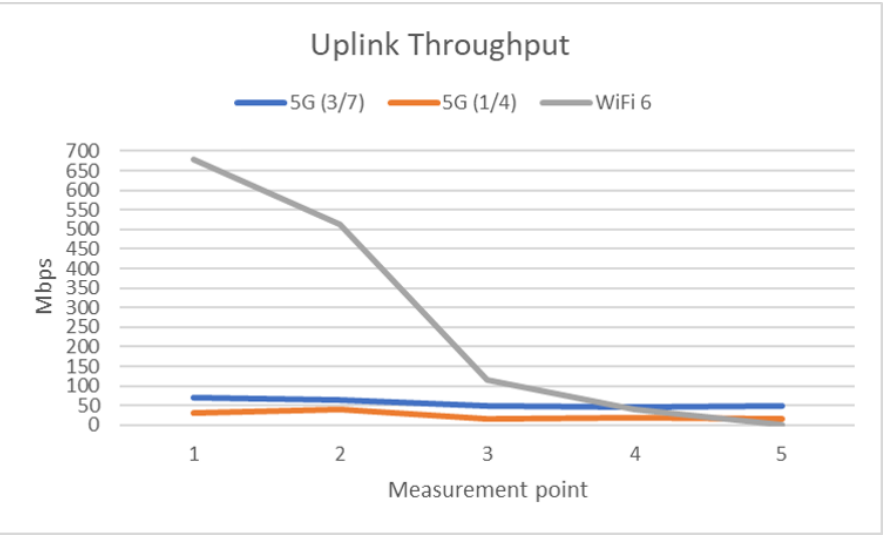
Figure 4. UL Peak Throughput.